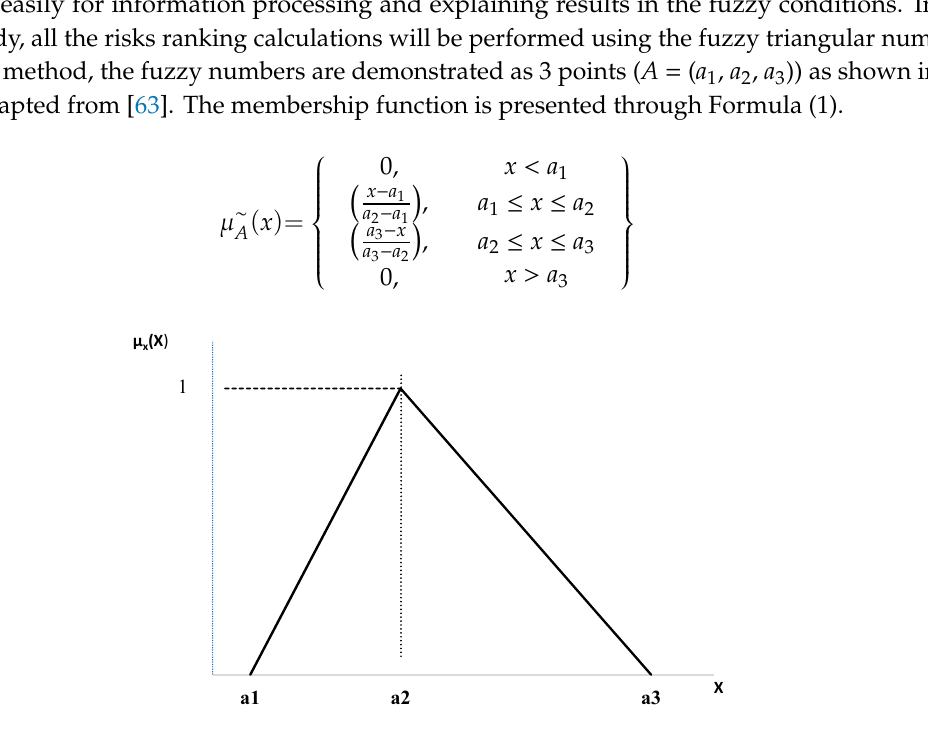
Figure 2. Demonstration of the triangular fuzzy number.